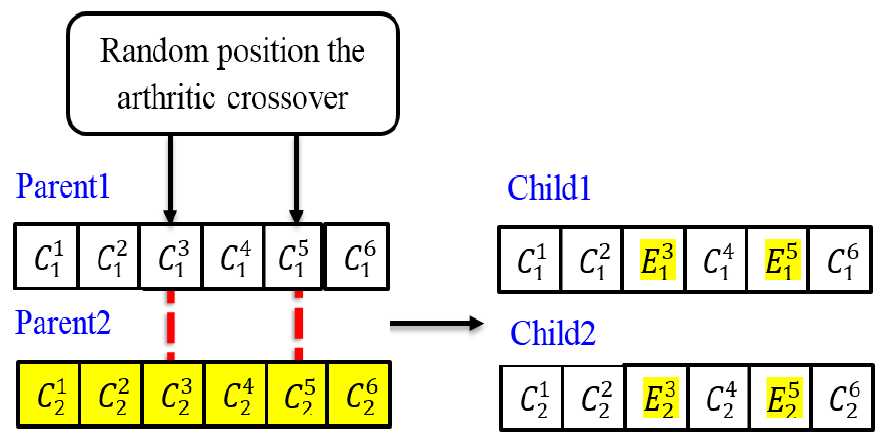
8 of 21 Figure 9. DC bus voltage (V). 8. Arithmetic Crossing (Barycentric) The inventor of this method is “MICHALEWICZ”. We select the exchange places for this kind of crossover at random, followed by an arithmetic mean weighted by a coeffi- cient a. Two children (offspring) E 1 (i) and E 2 (i) are produced when this procedure is carried out to the two parents C 1 (i) and C 2 (i) , as shown in [29]: {E 1 (i) = a C 1 (i) + (1 − a)C 2 (i) E 2 (i) = (1 − a)C 1 (i) + aC 2 (i)